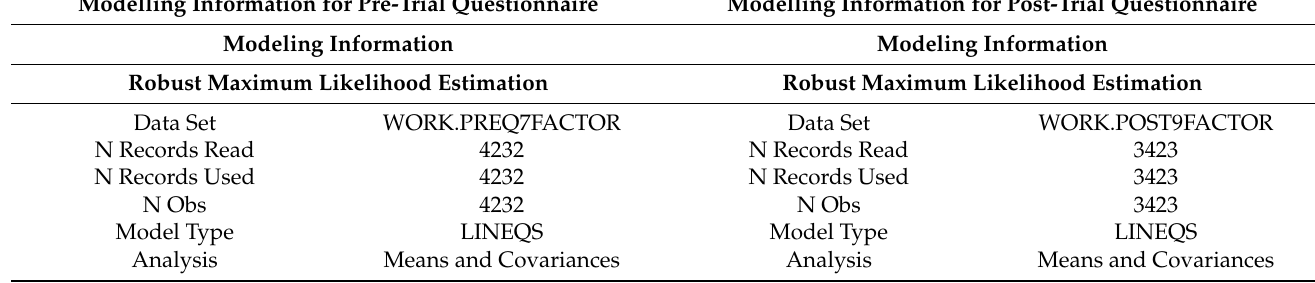
Table 3. Modelling information.